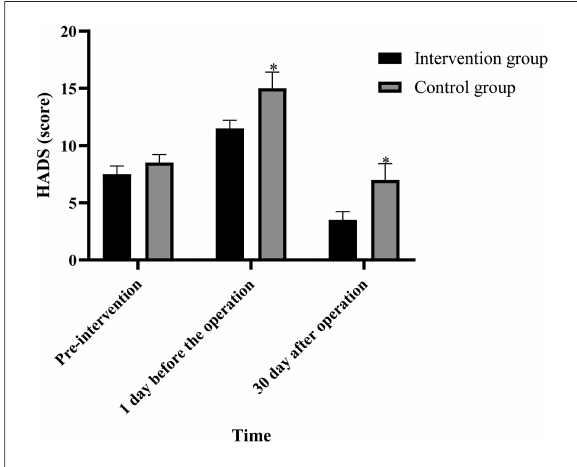
FIGURE 2 Comparison of HADS scores in two groups at different times (Note: compared with the intervention group, * P